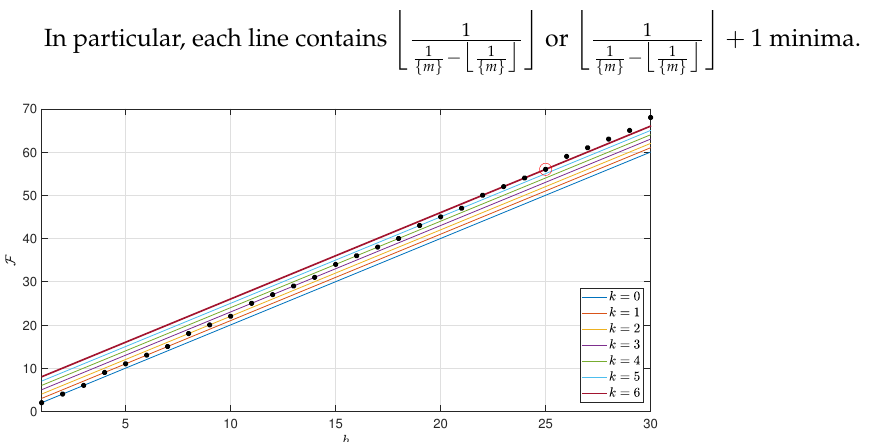
Figure 3. Set F representing the bundle of parallel straight lines passing related to the minima of ( z ) = 91 and n = 131), for different values of k j j ≥ 0 (when a